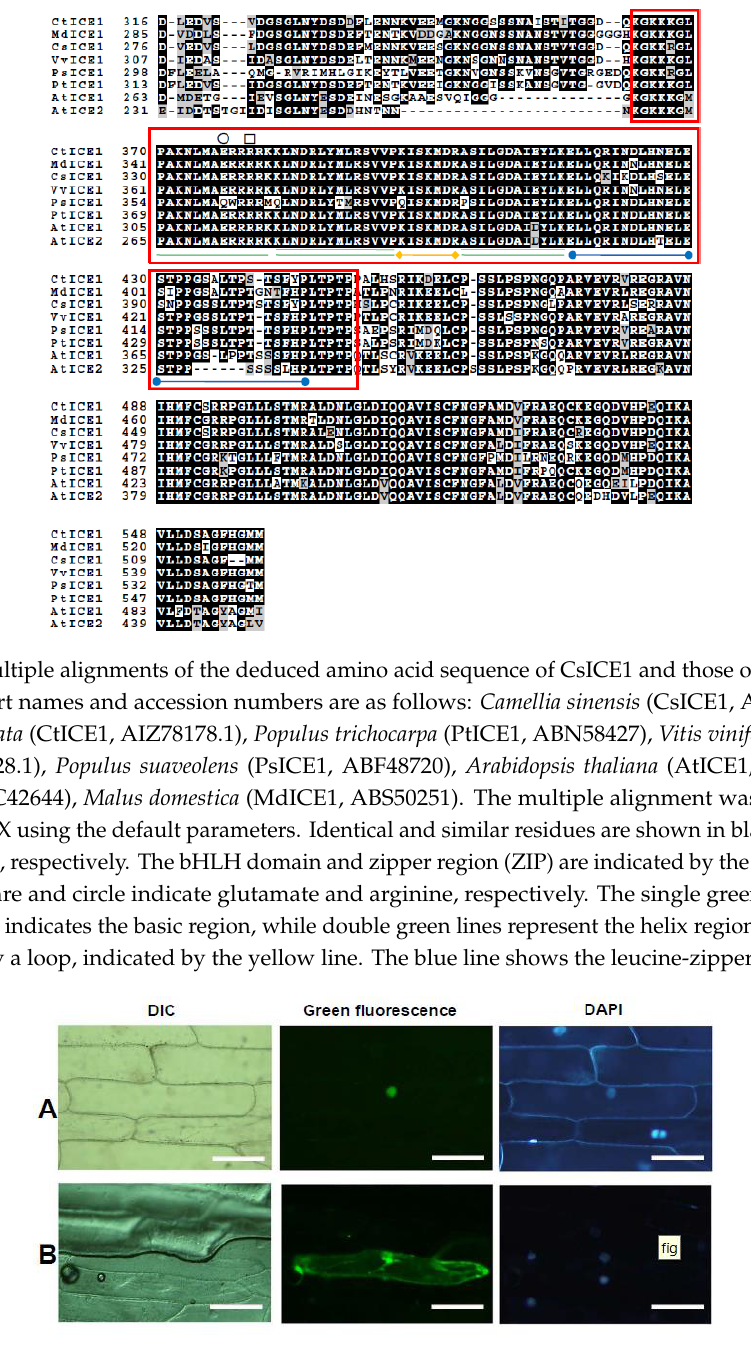
Figure 2. Subcellular localization of CsICE1 protein in onion epidermal cells. Onion epidermal cells were transformed with fusion vector CsICE1-GFP ( A ) and control vector GFP ( B ). Images were obtained in bright light to observe the morphological characteristics, in a dark field to detect green fluorescence of the cells, and 4’,6-Diamidino-2-Phenylindole, Dihydrochloride (DAPI) staining. Bar = 100 μm. DIC: differential interference contrast.